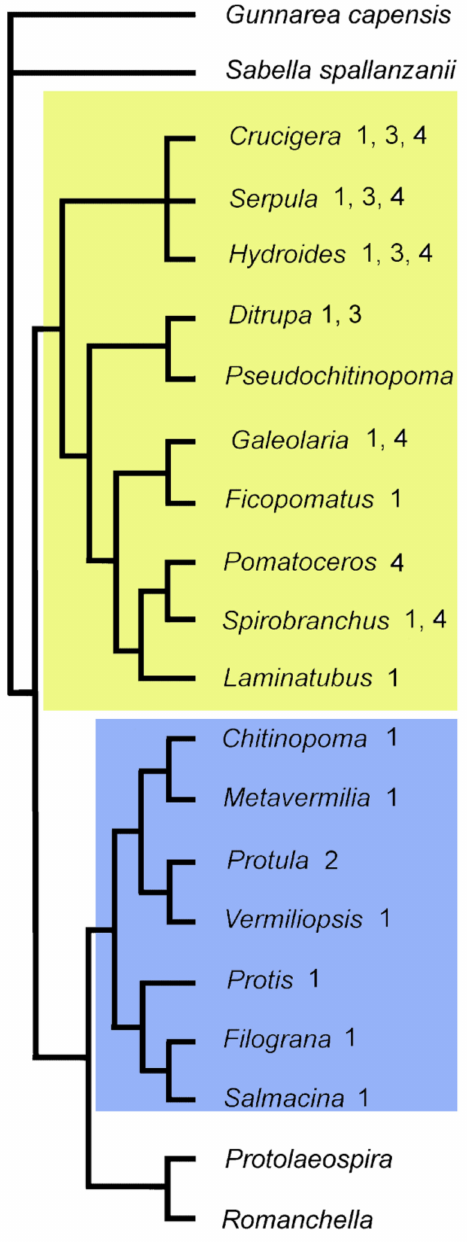
Figure 10. Evolution of serpulid tube microstructures. Phylogenetic relationships of serpulid genera derived from Kupriyanova et al. [67]. Numbers indicate: 1, unoriented structures; 2, semi-oriented structures; 3, oriented prismatic structures. Serpulids with dominantly calcitic mineralogy or with mixed composition are marked with yellow, and genera with dominantly aragonitic mineralogy are marked with